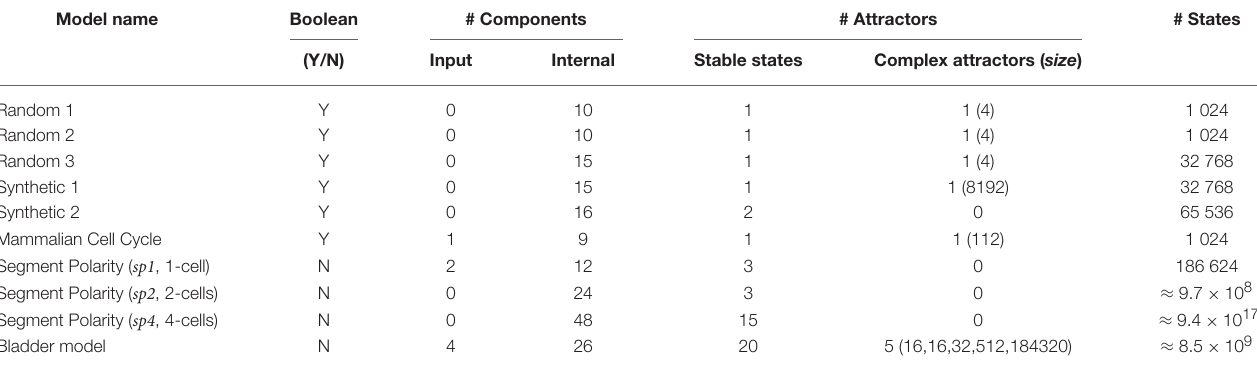
TABLE 1 | Characteristics of the models used as case studies to challenge Firefront and Avatar: type of variables (Boolean vs. multi-valued), number of input components (these remain constant) and internal components, number and type of attractors with number of states in the case of complex attractors, size of the state space with the total number of model